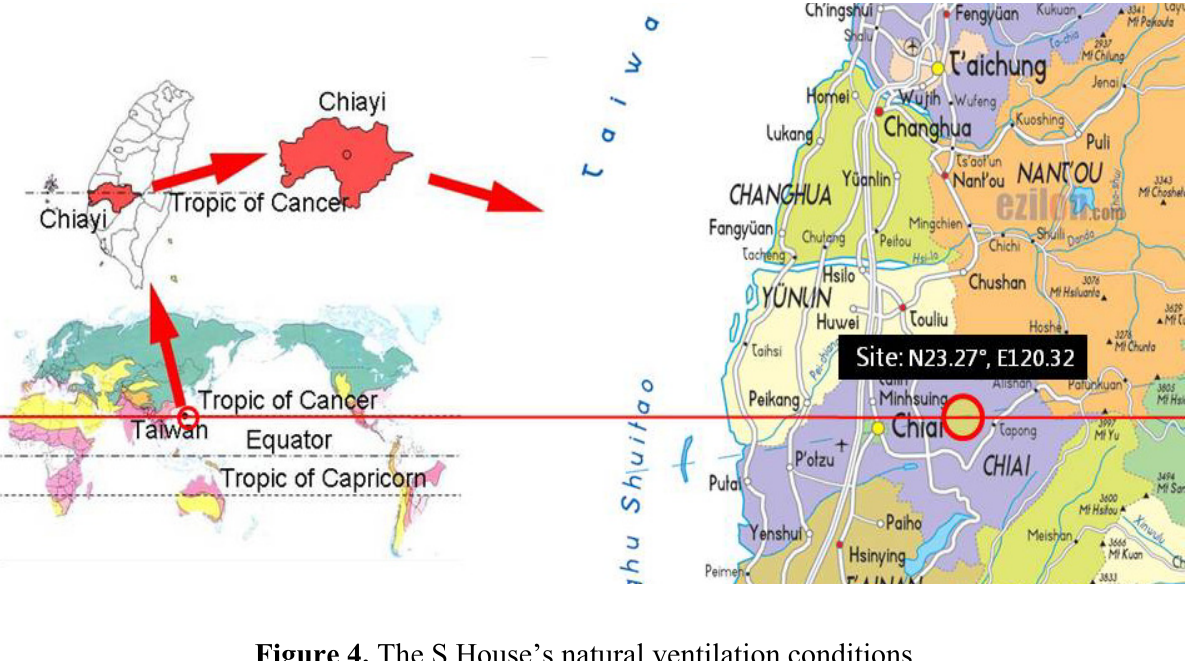
Figure 3. The S House is near the Tropic of Cancer.